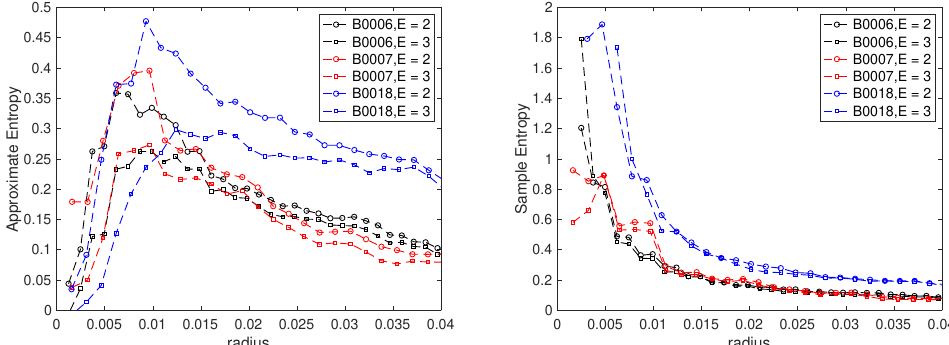
Figure 9. Approximate and sample entropies for the B0006, B0007 and B0018 data sets for different embedding lengths and radii.